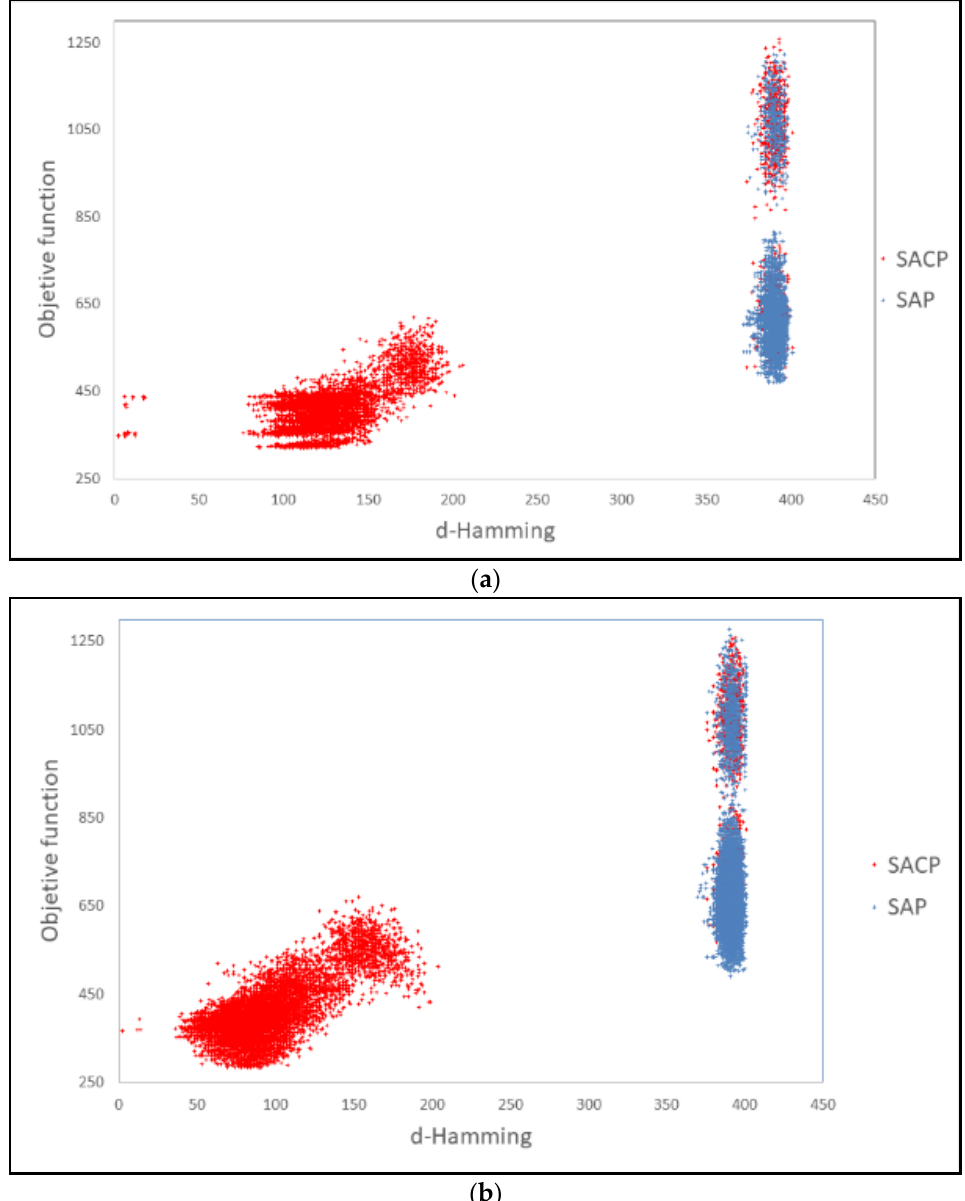
Figure 8. Processes with cooperation SACP and without cooperation SAP, in function of d-Hamming with 48 processes. Results of 30 tests. ( a ) Instance large01. ( b ) Instance large02.